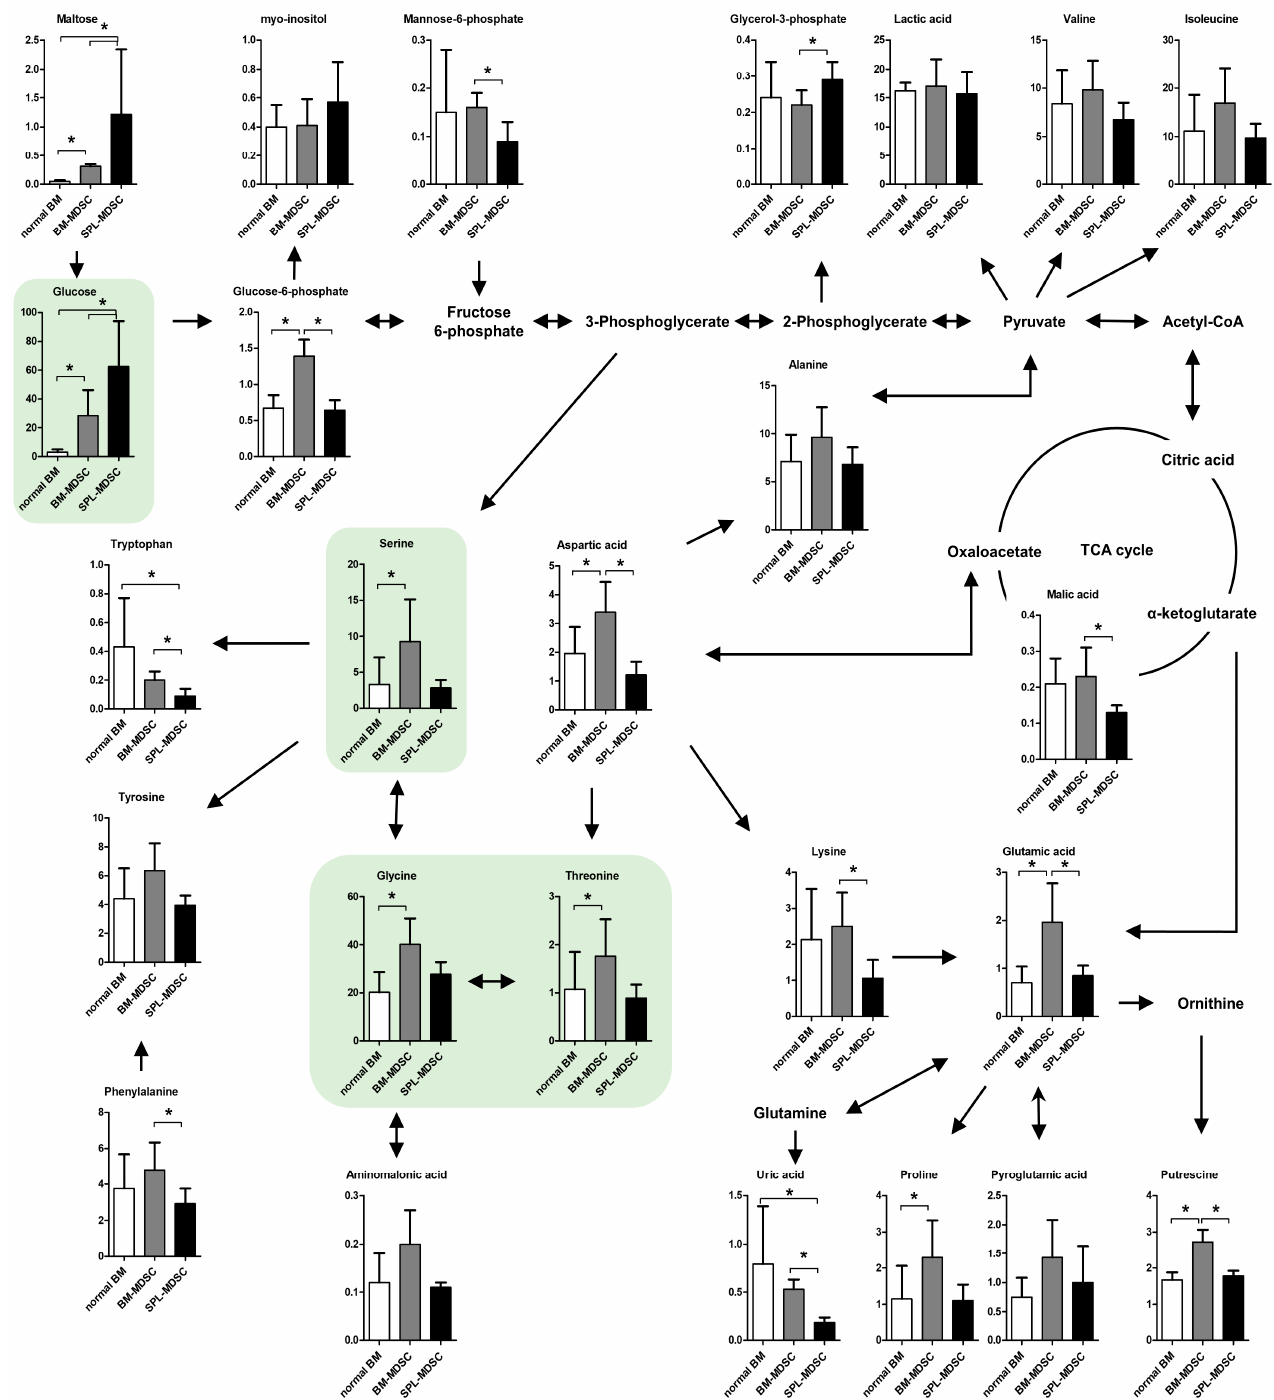
Figure 1. Comparative metabolomic profiles in BM cells and MDSCs. The proposed metabolic pathway is presented based on data in the KEGG database (http://www.genome.jp/kegg/, accessed on 4 November 2022). Each value represents the mean ± standard deviation (SD) ( n = 6, three biological and two experimental replicates). *, p < 0.05. Green boxes indicate SGOC-pathway-related metabolites. The p values were obtained by a Mann–Whitney U